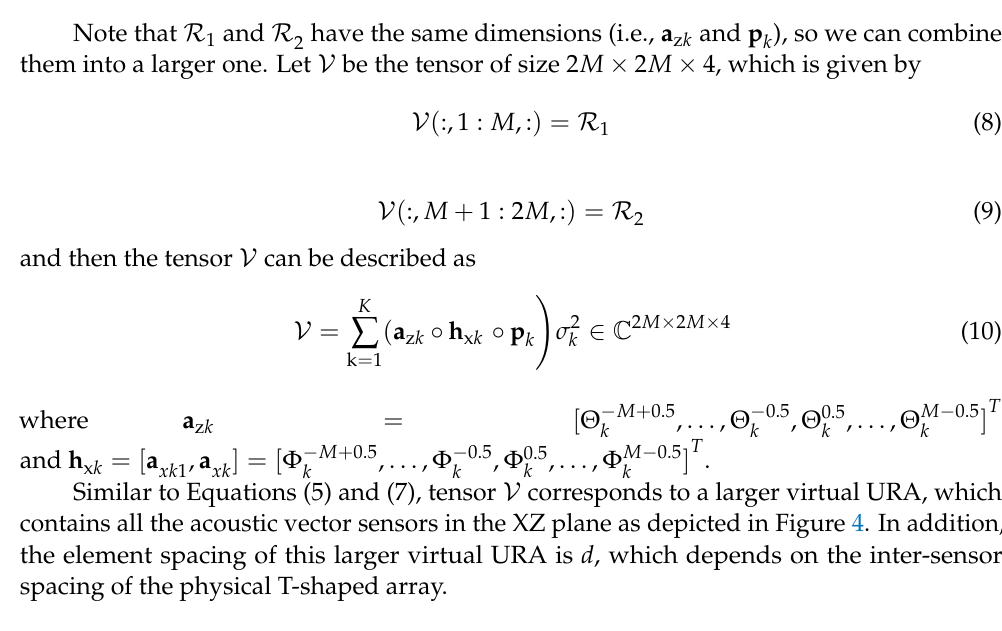
Figure 3. Virtual URA with Acoustic Vector Sensors in the right half of the XZ